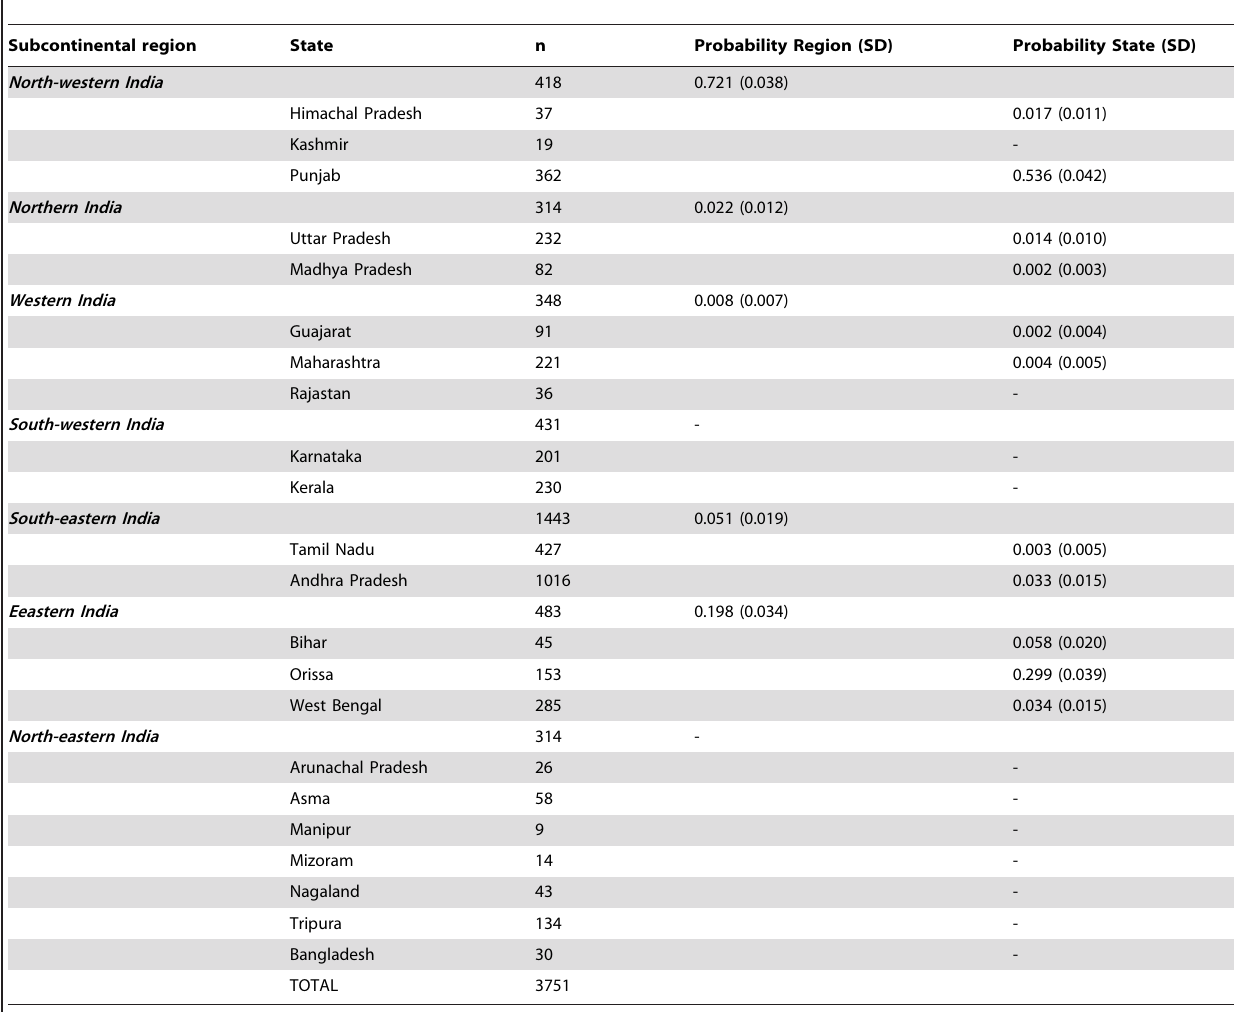
Those regions/states with no matches with Roma sequences (probability=0) are shown with hyphens (-). doi:10.1371/journal.pone.0015988.t003 PLoS ONE |